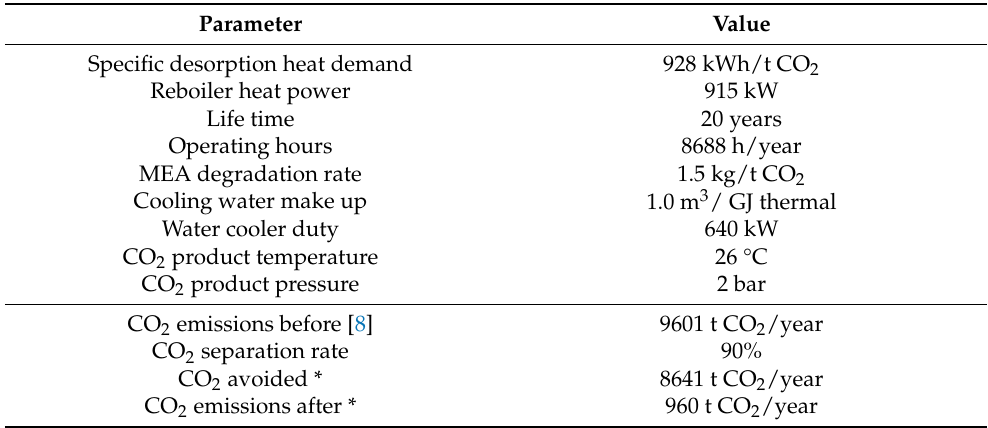
Table 4. Operation parameter of the designed CO 2 absorption plant. All parameters are based on [49], unless indicated otherwise. * Own simulations. Parameter Value Specific desorption heat demand 928 kWh/t CO 2 Reboiler heat power 915 kW Life time 20 years Operating hours 8688 h/year MEA degradation rate 1.5 kg/t CO 2 Cooling water make up Water cooler duty 640